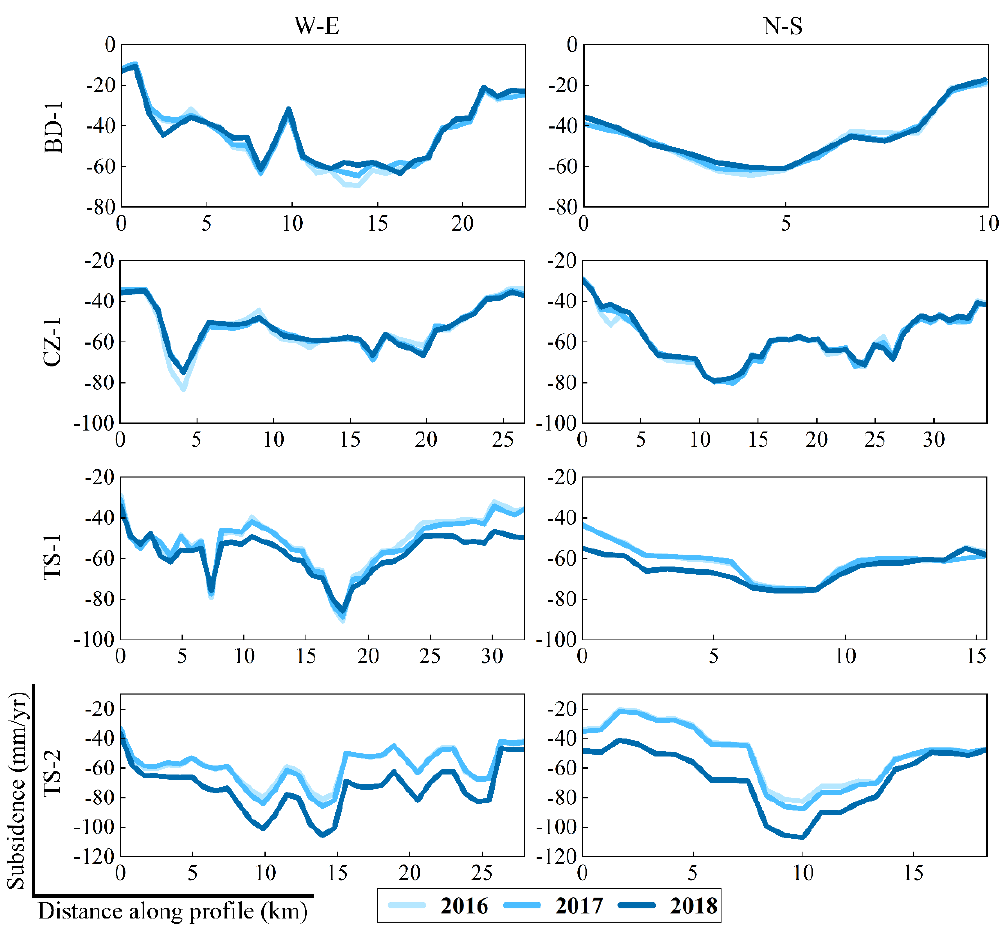
Figure 6. Part of profiles of the InSAR vertical displacement (2016–2018) marked by the black dashed lines in Figure 5.